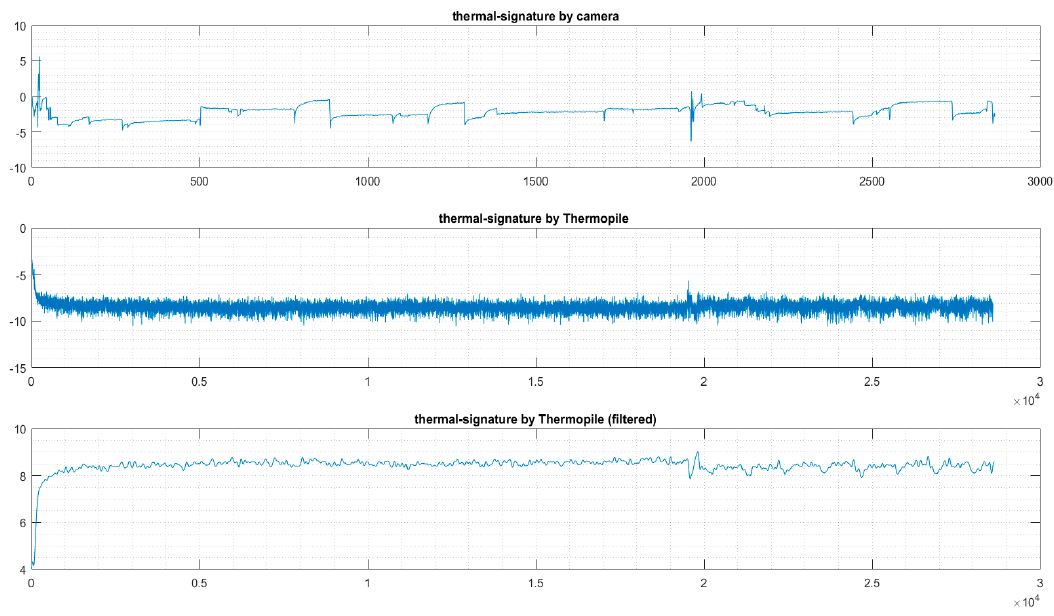
Figure 2. The thermal signatures obtained with the thermal camera and the thermopile sensor.